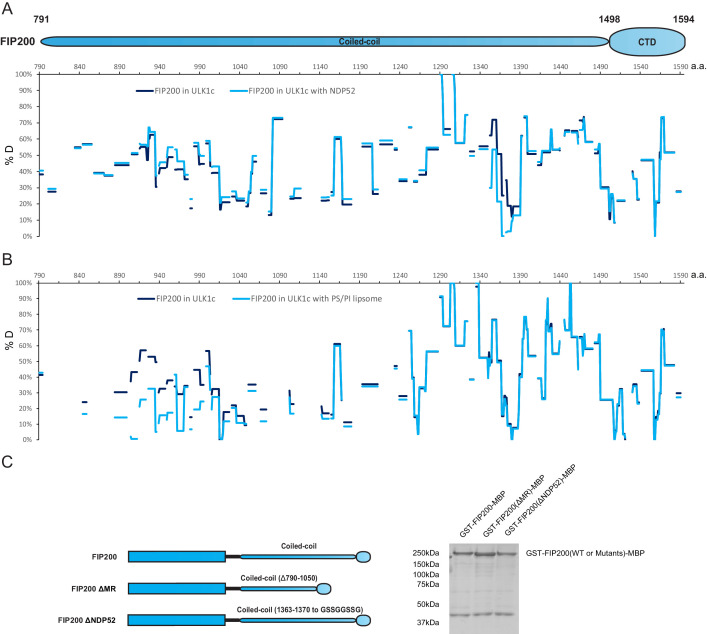
The coiled-coil domain of FIP200 is involved in binding with NDP52 and membranes, but not its stability.(A) Hydrogen Deuterium Exchange percentages of FIP200 in ULK1 complex (Purple) and in ULK1 complex with NDP52 (Blue) at the 60 s time point. (B) Hydrogen Deuterium Exchange percentages of FIP200 in ULK1 complex (Purple) and in ULK1 complex with POPS/POPI SUV (Blue) at the 60 s time point. (C) GSH resin was used to pull down GST-FIP200-MBP, GST-FIP200ΔMR-MBP and GST-FIP200ΔNDP52-MBP from lysate of overexpressing HEK cells. The pull-down results were visualized by SDS-PAGE and Coomassie blue staining.